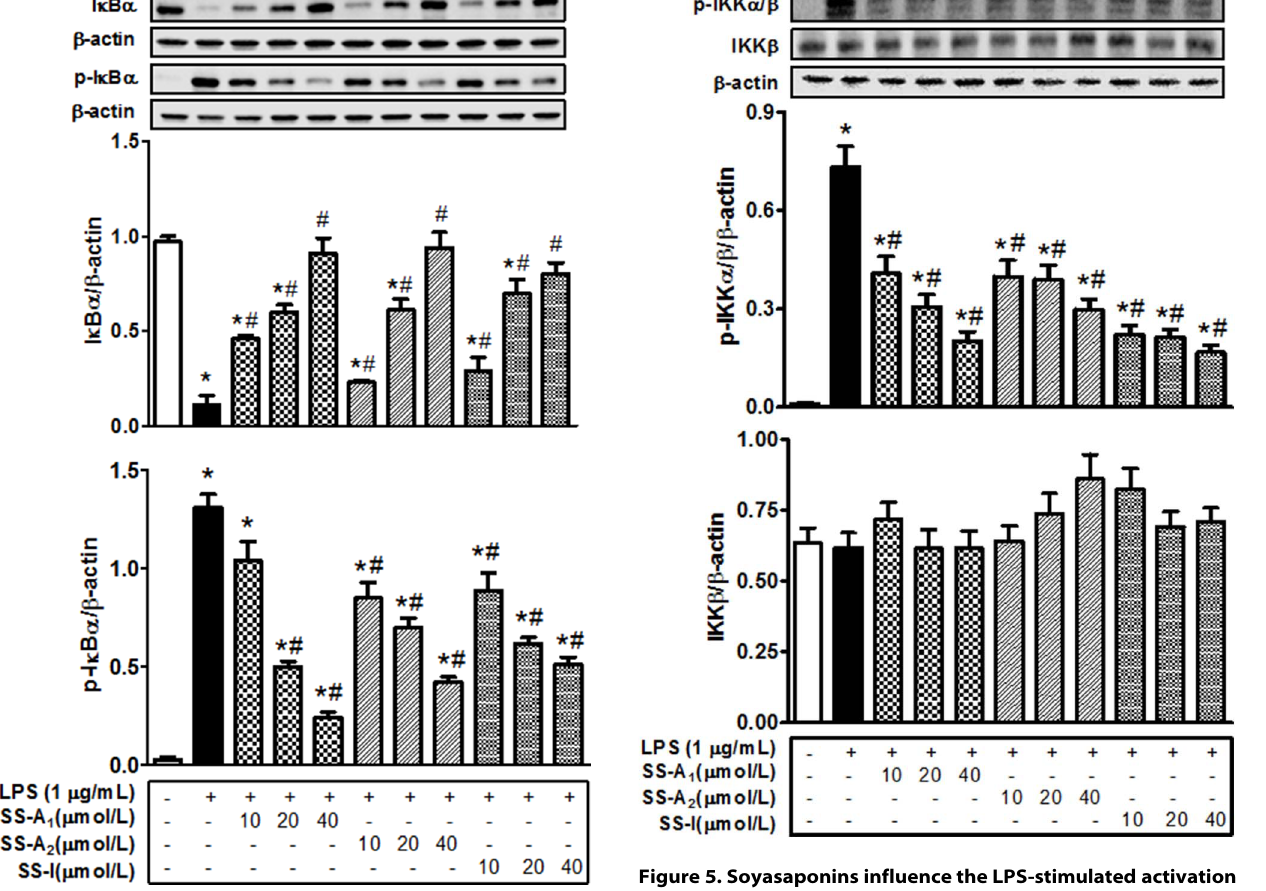
Figure 4. Soyasaponins influence the LPS-stimulated activation of NF-kB through modulating the degradation and phosphor- ylation of IkB a in macrophages. Macrophages were pre-treated with 10, 20, or 40 m mol/L of soyasaponins (A 1 , A 2 and I) for 2 h, and then stimulated with LPS (1 m g/mL) for 10 min or 30 min as indicated. Phosphorylation and degradation of IkB a were detected by immuno- blotting, and b -actin was used as a control. Results are presented as means 6 SD of 3 independent experiments. *: P , 0.05 vs. control. # : P , 0.05 vs. LPS alone.